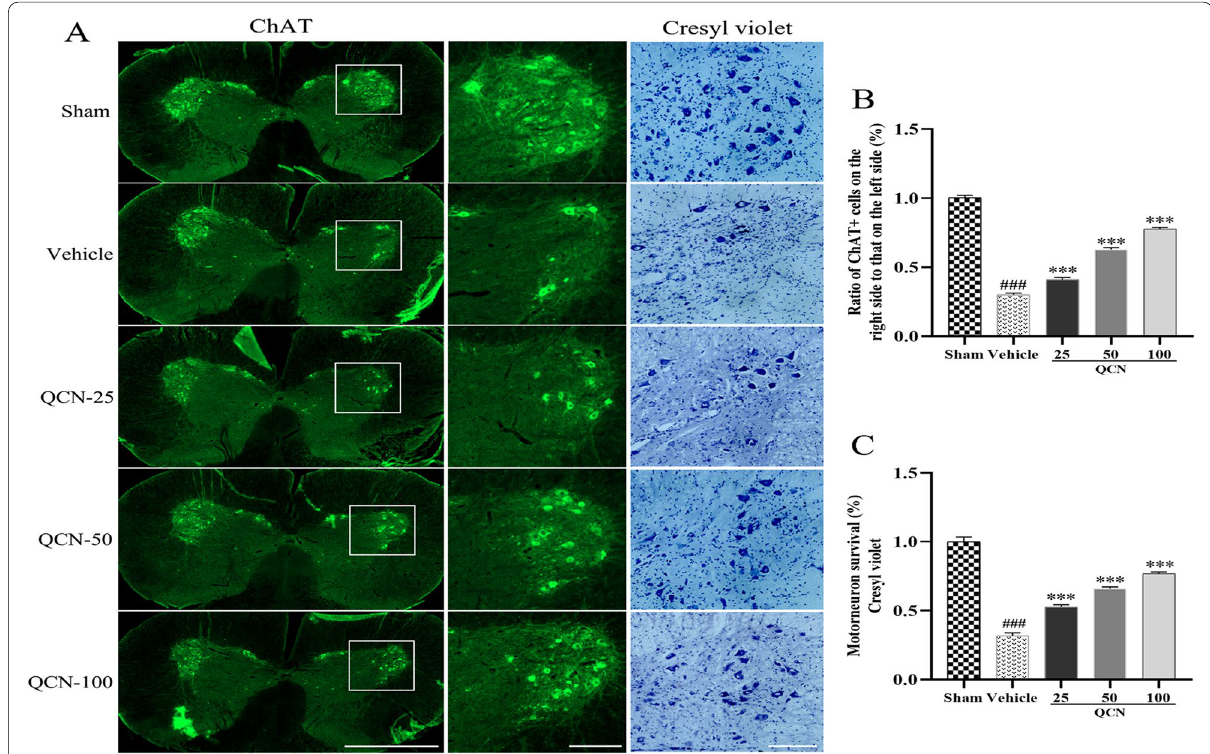
Fig. 3 Effects of QCN on survival of injured motoneurons of the BPA rats at week 8 post‑avulsion. Representative images of A ChAT and cresyl violet staining motoneurons in the ipsilateral C6–7 ventral spinal segments. The survival rate of B ChAT‑positive motoneurons and C Cresyl violet stained motoneurons of each group in the ipsilateral to contralateral ventral spinal segments at week 8. Data are expressed as the mean p < 0.001 vs the sham group; *** p < 0.001 vs the vehicle group. Scale bar 100 μm for ChAT on the left; 200 μm for ChAT on the right; and 200 μm for cresyl